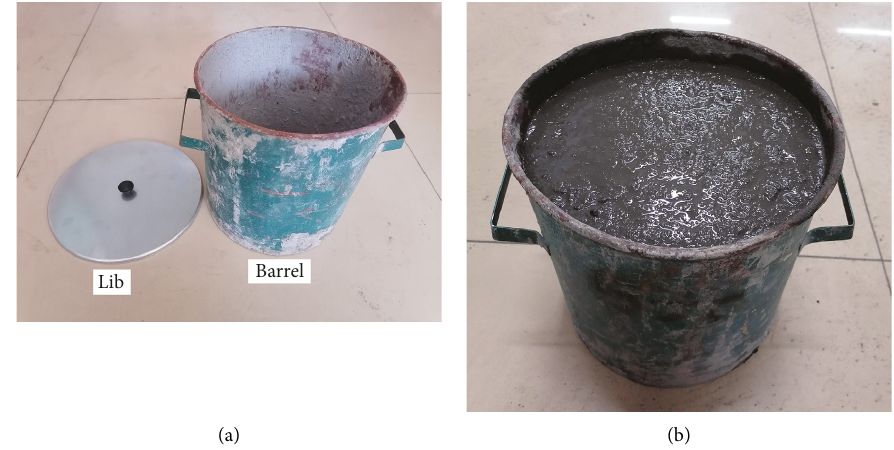
Figure 6: Photos of bleeding ratio test. (a) Measuring device. (b) Bleeding ratio